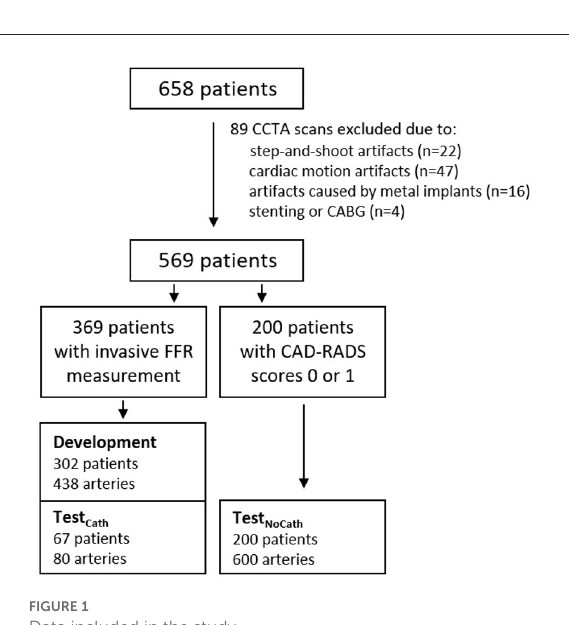
FIGURE1 Data included in the